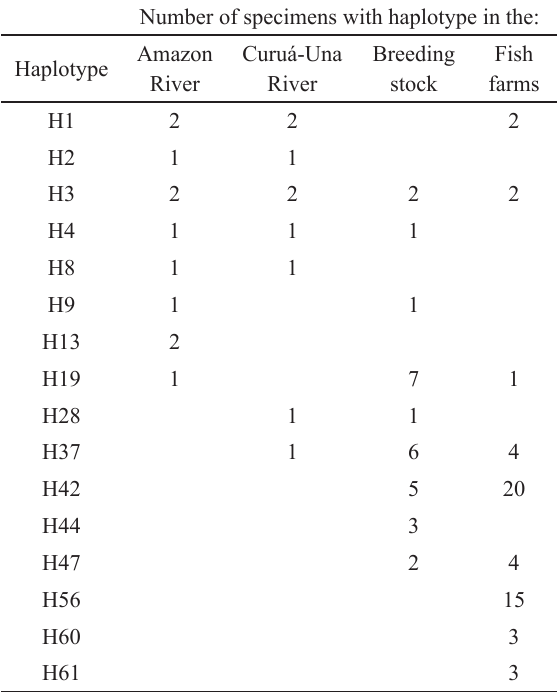
Frequency of the 16 shared haplotypes in the four study populations of C. macropomum